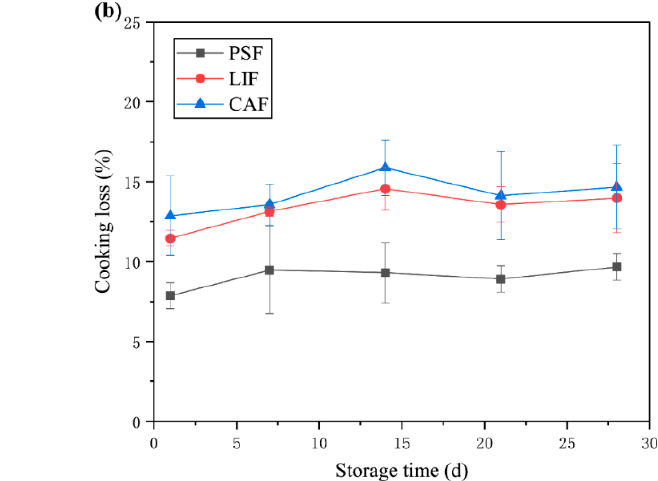
Figure 1. Thawing loss ( a ) and cooking loss ( b ) changes in largemouth bass during frozen storage with different freezing methods. Acronyms: PSF = pressure–shift freezing; LIF = Liquid immersion freezing; CAF = Conventional air freezing.